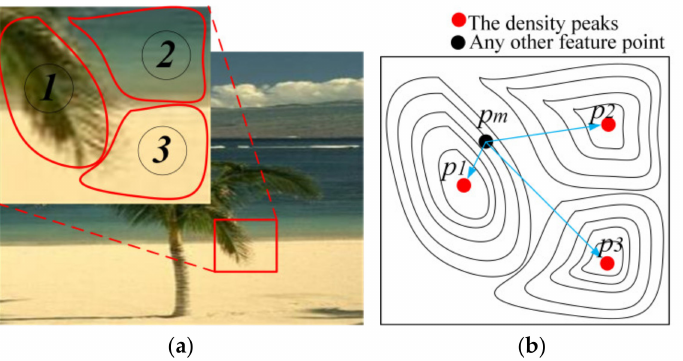
Figure 4. The probability distribution of the points. ( a ) The superpixel segmentation schematic diagram. ( b ) The density peaks and the contour maps are used to describe the density distribution of the other